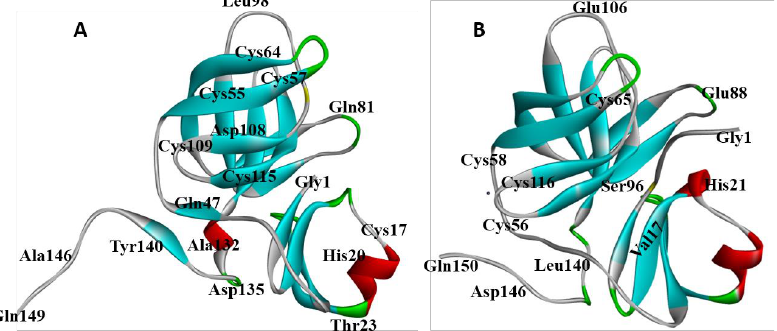
Figure 4. 3D and crystalline structures of respectively; ( A ) poliovirus 2A pr ° and ( B ) Coxsakievirus B4 1z8r as predicted by the Modeller v. 9.14 program [31].